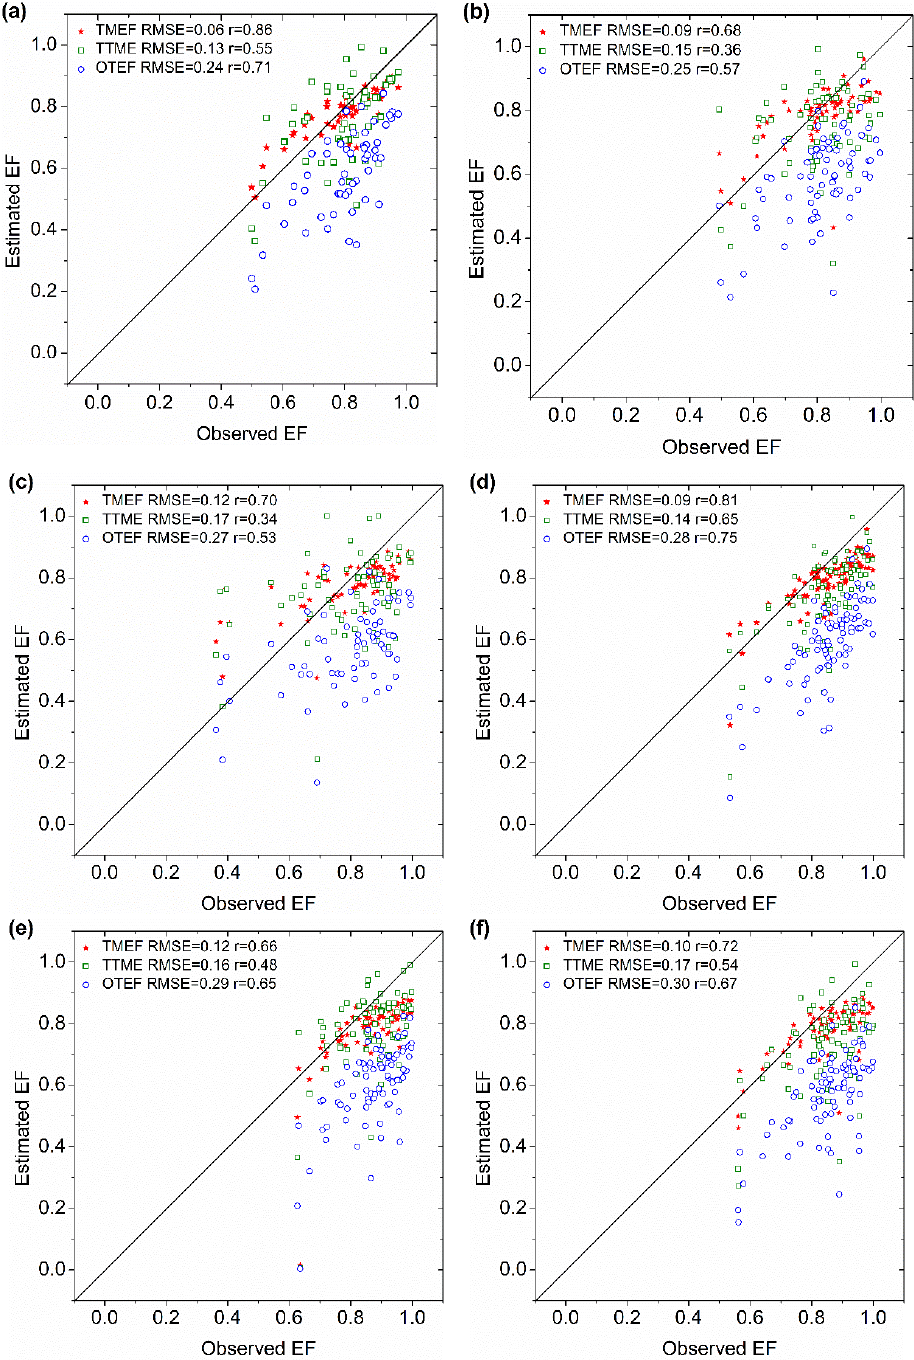
Figure 4. Comparison of estimated EF between the TMEF, TTME, and OTEF models where ( a – f ) corresponds to the flux sites of NO. 7, NO.10~No. 14.